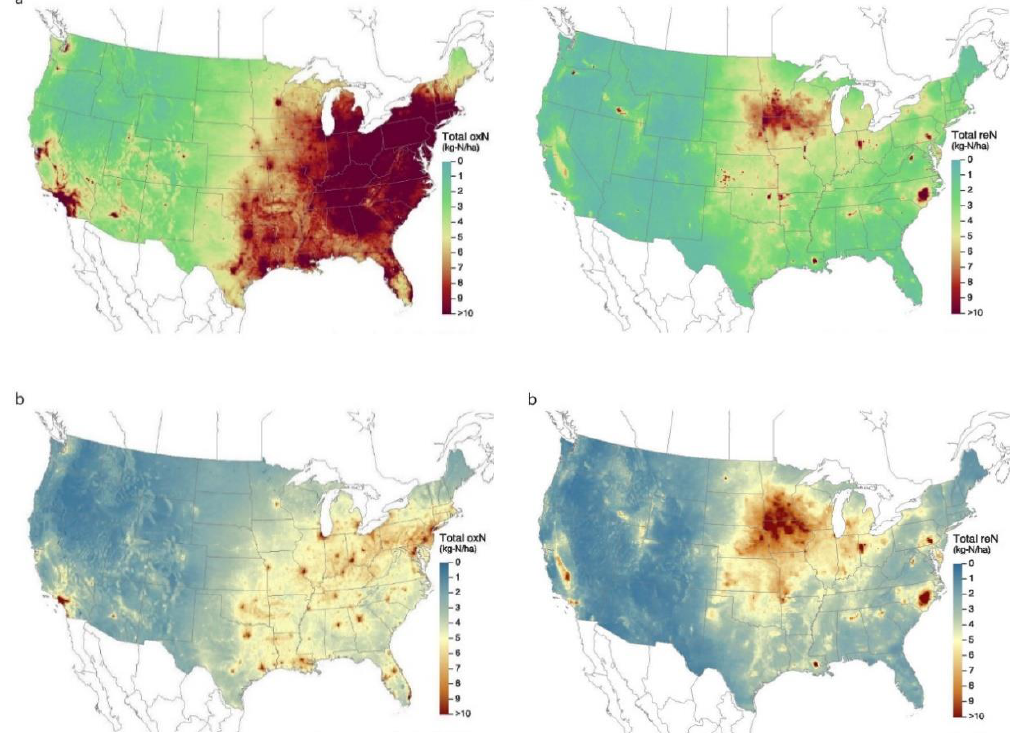
Figure 2. Total oxidized N and total reduced N deposition. Figures marked ( a ) are from 2000; figures marked ( b ) are from 2014. Reprinted with permission from ref. [28]. Copyright 2019 Gilliam et al.